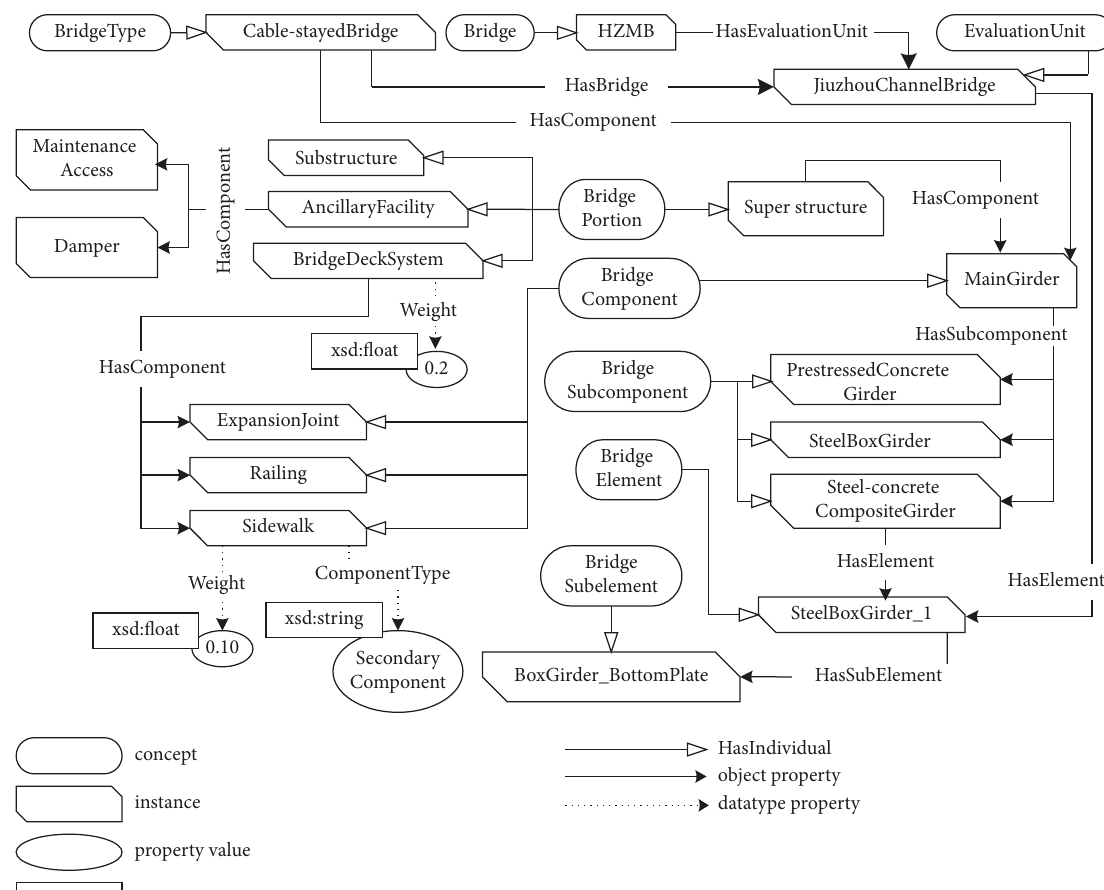
Figure 4: A schematic of the bridge structure ontology (partial view). HZMB denotes the Hong Kong-Zhuhai-Macao